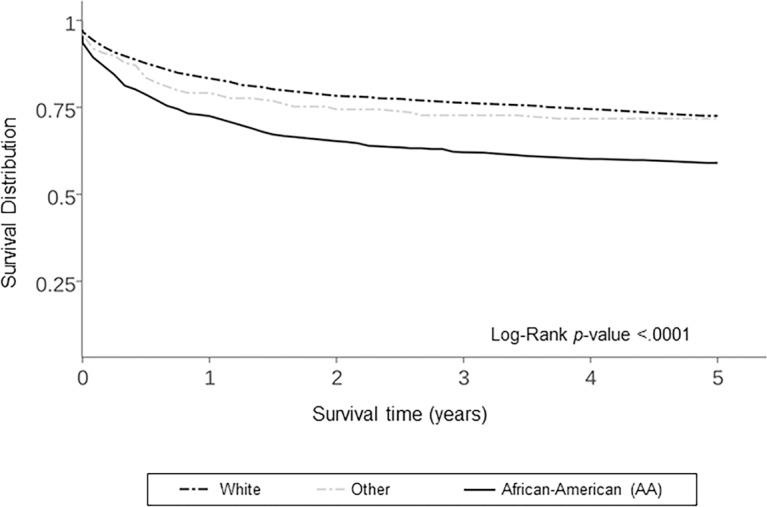
KS survival in the U.S. by Race, 2000–2013, N = 3,793.